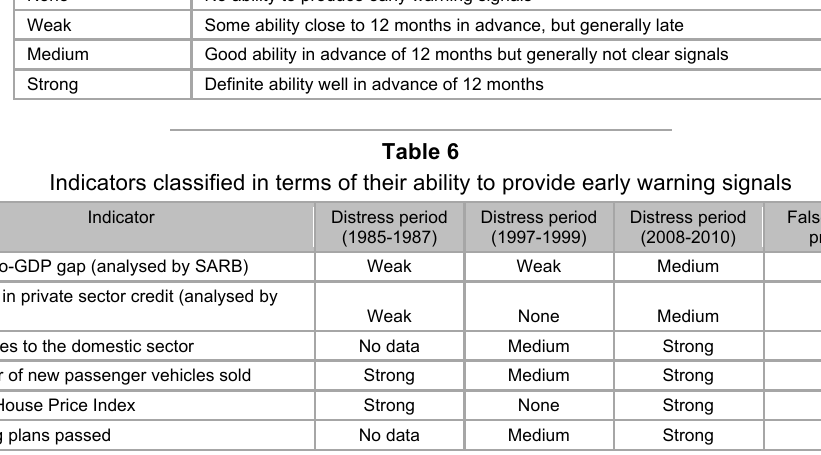
Classification scheme for the ability of indicators to produce early warning signals